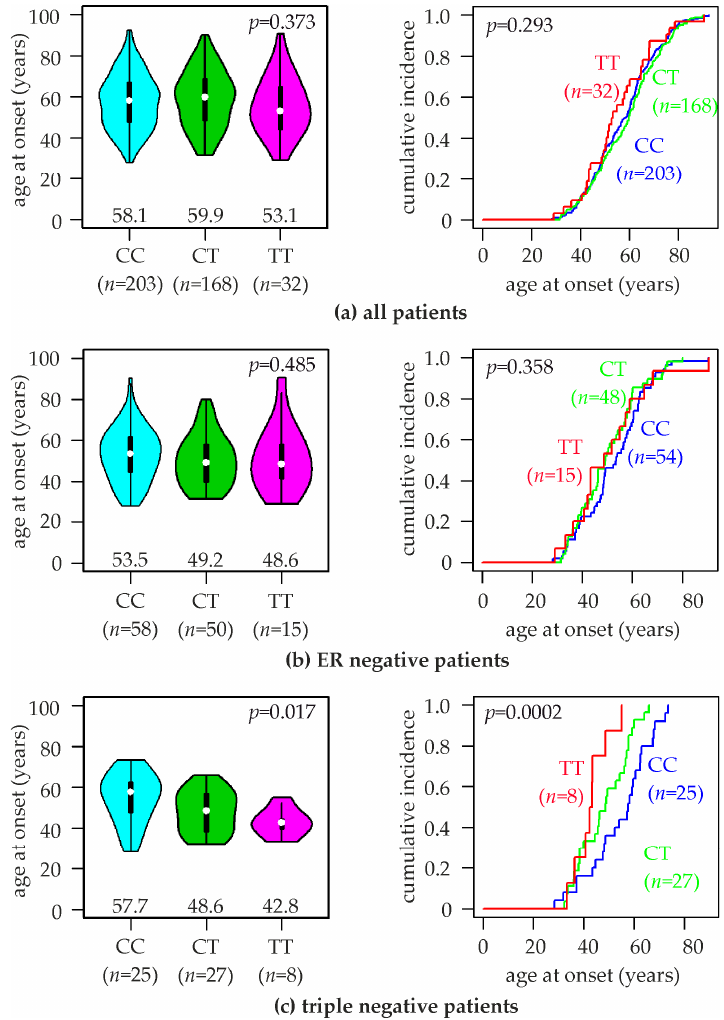
Figure 1. Association of rs10069690 genotypes with the age of breast cancer onset. Violin plots (left) and curves of the cumulative breast cancer incidence (right) with the indicated age of onset are shown for ( a ) all patients in the study population, ( b ) ER-negative, and ( c ) triple-negative patients. rs10069690 genotypes (CC, CT, TT) and numbers of patients ( n ) are indicated. Numbers in the left panels represent the median age of breast cancer onset for each genotype (indicated by white dots). P -values ( p ) in the left panels were calculated with Kruskal-Wallis tests and in the right panels with log-rank tests.